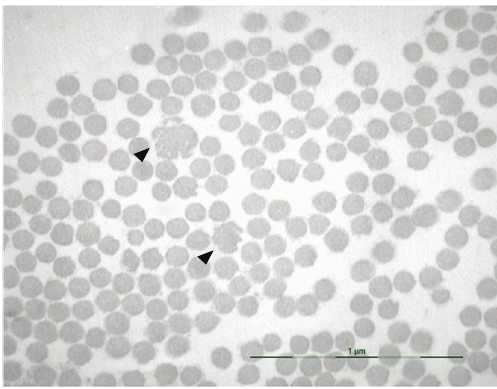
Figure 1: Flower-like collagen fibrils ( (cid:2) ) and irregular interfibrillar spaces.